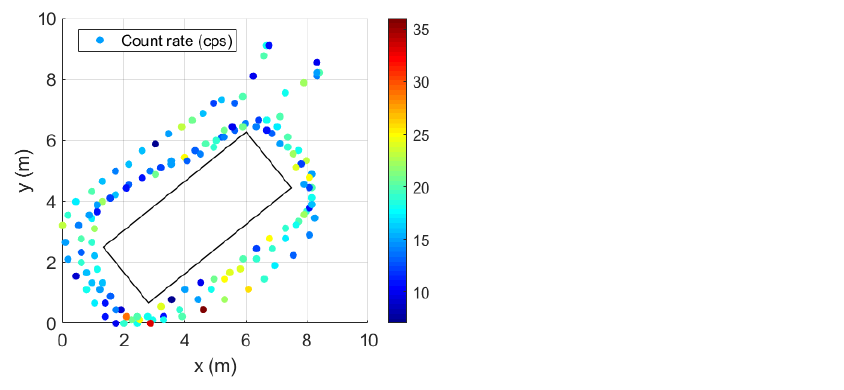
Figure 17. EJ-200 scintillator gamma-ray count rate (cps) of the background surrounding the shipping